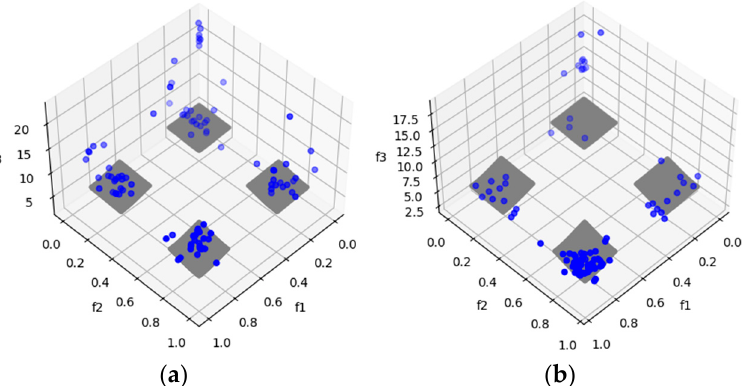
Figure 8. The plots of the approximate PFs with the highest HV value against real PF. ( a ) DTLZ7 approximate PF using MOSA/D-CGO; ( b ) DTLZ7 approximate PF using MOSA/D-DE.